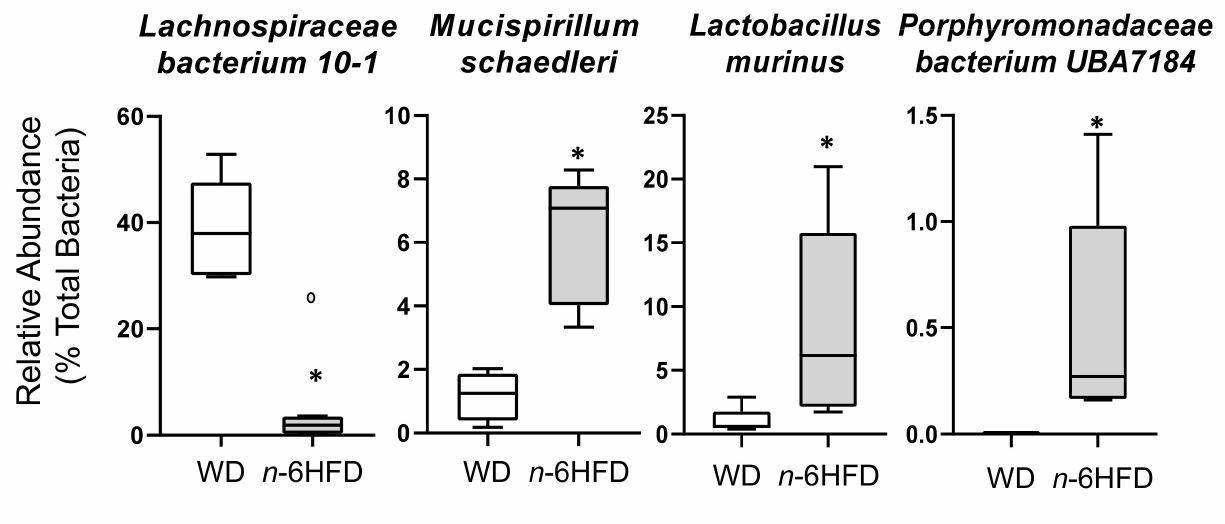
Figure 11. Species-relative abundances of bacteria at 16 weeks of age. Medians with an asterisk (*) differ, p <